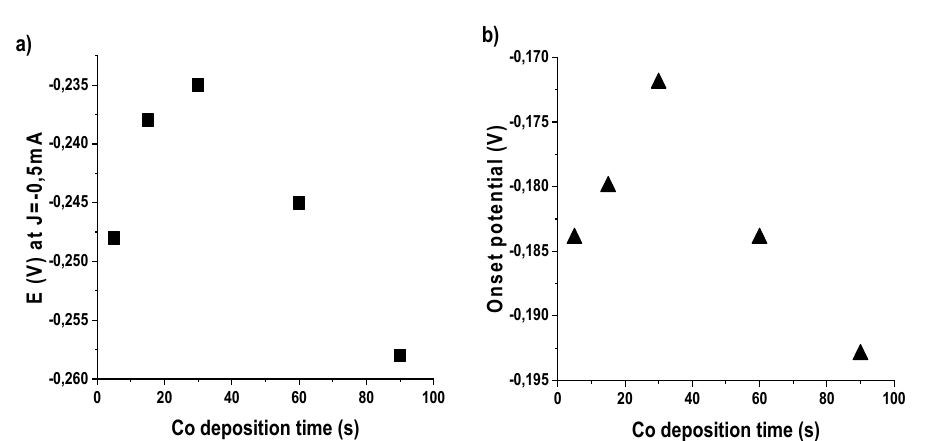
Figure 2. Volcano curves as obtained by plotting: ( a ) the potential values at j = − 0.5 mA · cm − 2 ; and ( b ) onset potential values versus time of Co electrochemical deposition.